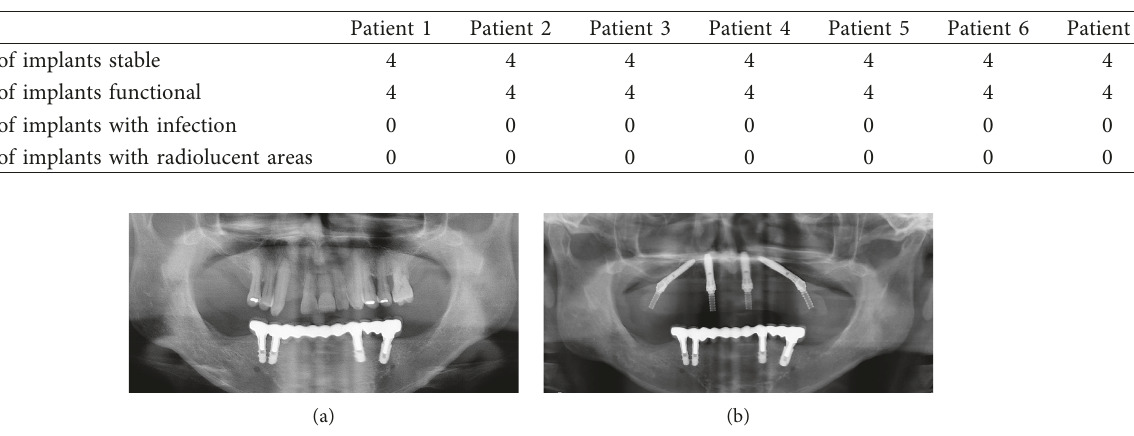
Table 2: Implant survival rate.